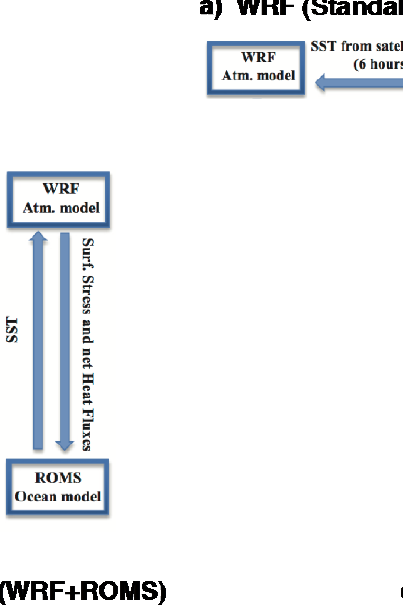
Figure 5. The three different configurations adopted in this study. Panel ( a ): WRF run: atmosphere standalone (WRF uses the SST data from the RTG_SST dataset, every 6 h). Panel ( b ): AO (Atmosphere-Ocean) run: coupling between atmosphere and ocean (WRF receives the SST from ROMS model, at 1 km resolution, every 300 s, and exchanges the turbulent heat fluxes with ROMS). Panel ( c ): AOW (Atmosphere–Ocean–Wave) run: full atmosphere-ocean-wave coupling (WRF and ROMS exchange SST and fluxes; WRF and SWAN exchange the wind fields and the wave parameters; ROMS and SWAN exchange currents fields and wave parameters).